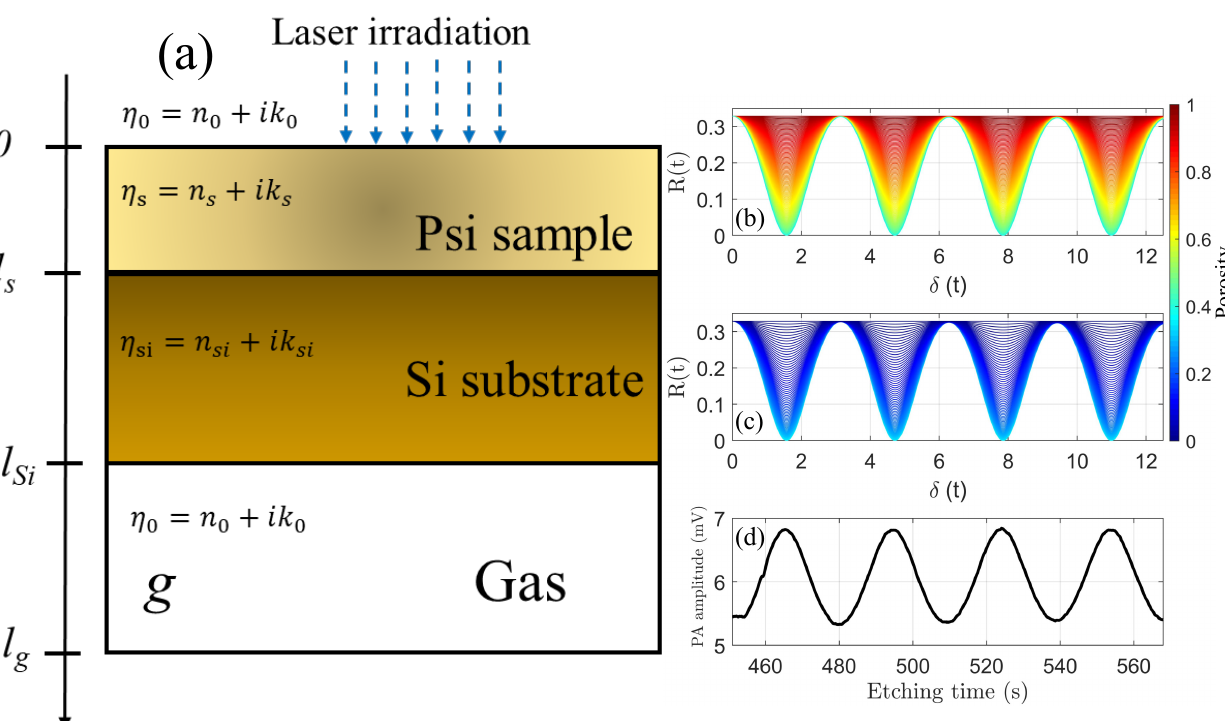
Figure 3. ( a ) Schematic sketch-view of an electrochemical cell coupled to a photoacoustic one during the PSi formation. ( b , c ) represent the reflectance of heterostructure as a function of the thickens of PSi Equation (13) and porosity. ( d ) is the PA amplitude as a function of the etching time for a sample anodized at 5 mA/cm 2